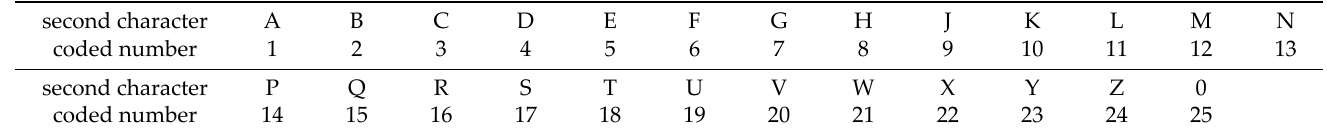
Table 2. Encoding the second character (city) in the license plate.